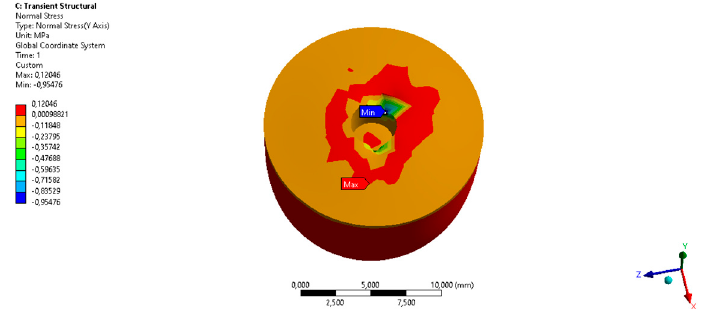
Figure 9. Thermal-Structural Analysis. Y-axis Normal Stress − 0.955 MPa.